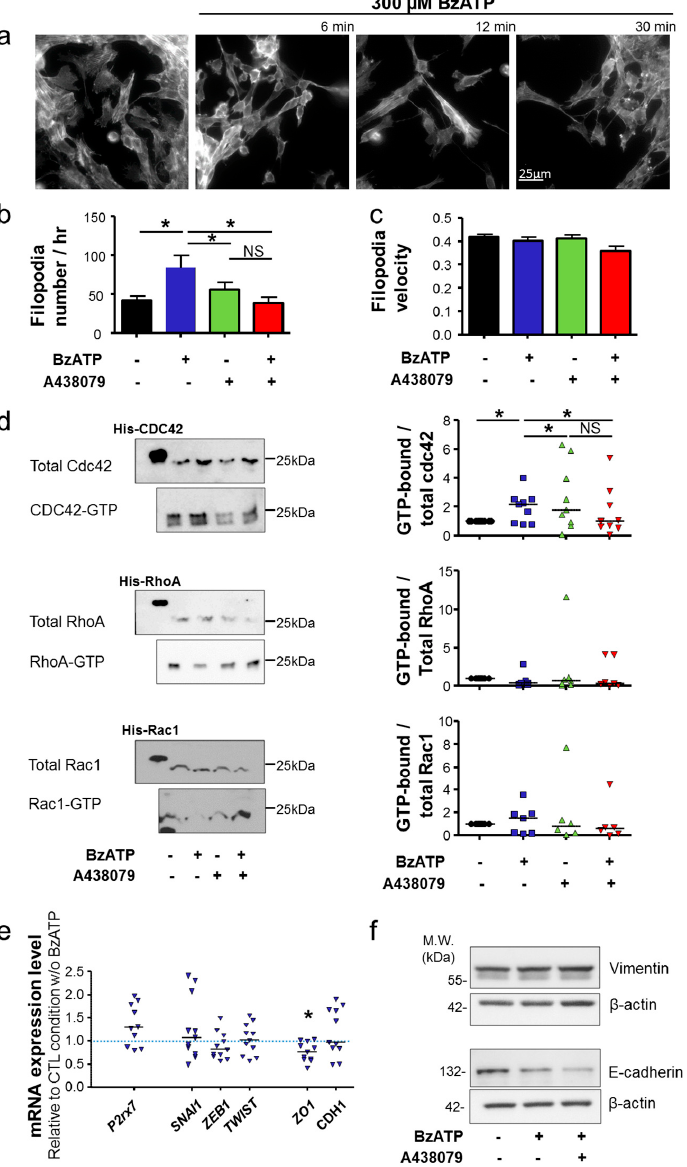
Figure 3. P2X7 receptor stimulation promotes the acquisition of a mesenchymal phenotype. ( a ) F-actin cytoskeleton was visualized using phalloidin-488 in 4T1 cells stimulated with 300 µM BzATP at the time indicated. Rapid morphological changes appear as rapidly as after 6 min stimulation. Scale bar, 25 µm. ( b ) The number of new filopodia per cell was counted per hour in cells transfected with the LifeAct plasmid and studied in the presence of 300 µM BzATP, in the presence or absence of 10 µM